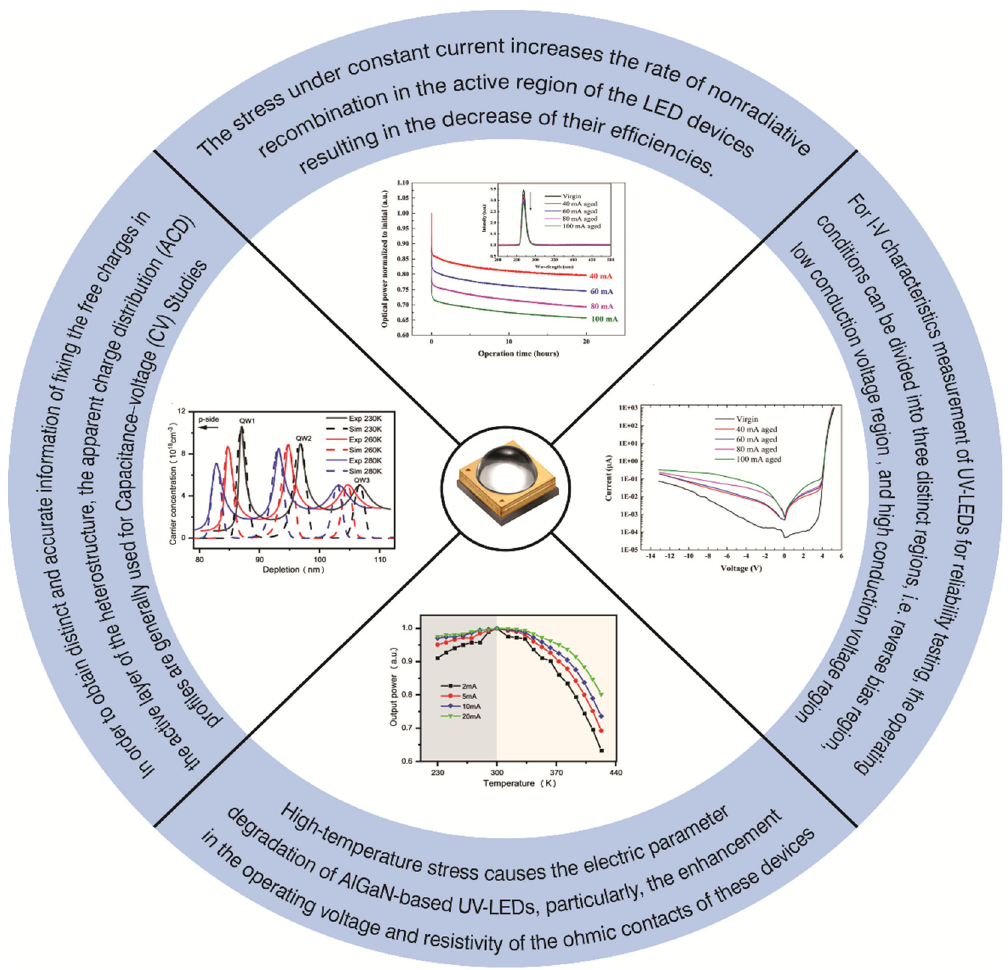
Figure 35. Reliability measurement scheme.